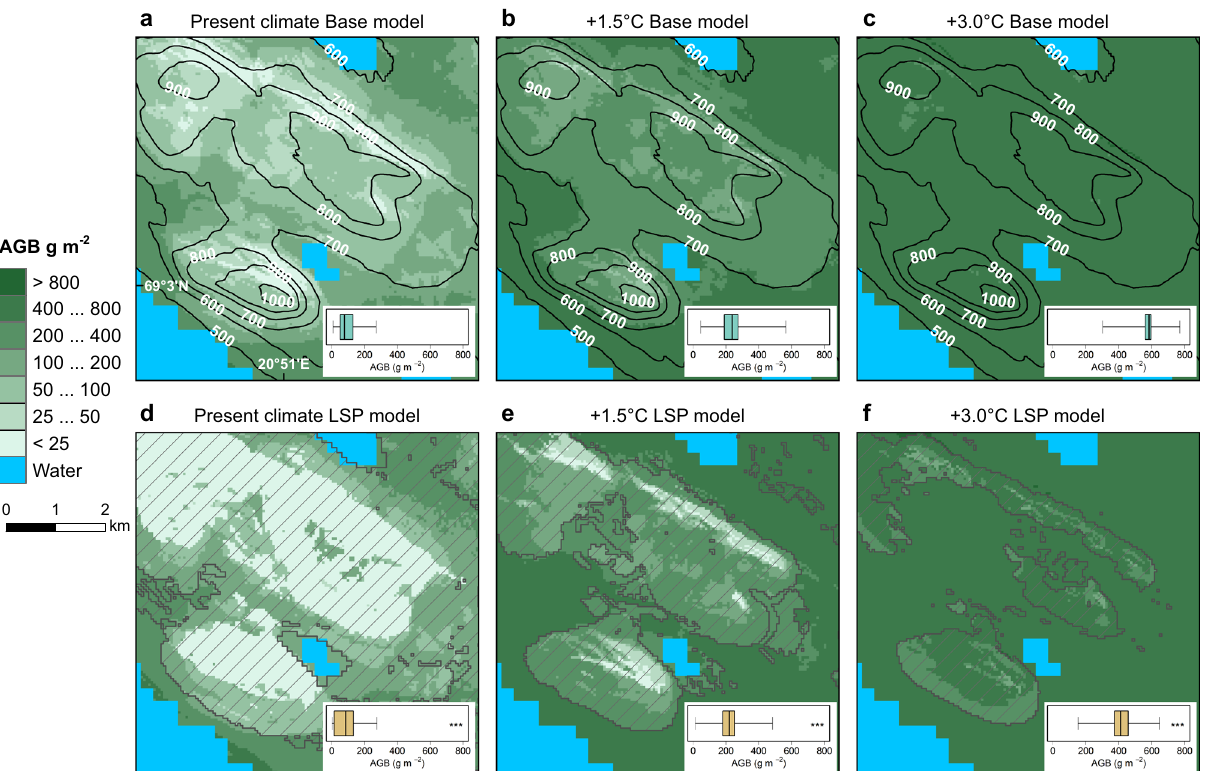
Fig. 4 Above-ground biomass (AGB) patterns in tundra are constrained by cryogenic land surface processes (LSP). The close-ups ( a – c Base model, d – f LSP model) show the predicted AGB in a topographically heterogeneous landscape (ca. 69°03 ’ N, 20°51 ’ E) at present climate (1981 – 2010), and under two mean annual air temperature warming scenarios (i.e., + 1.5 °C and + 3.0 °C), respectively. In a – c , the contours depict elevation from sea level; in d – f , the gray hatched polygons encompass the areas suitable for the occurrence of LSP (i.e., the LSP realm) at each warming scenario. The boxplots indicate the AGB variation (black line depicting median, the whiskers extending to 1 st and 99 th percentile) within the LSP realm. Asterisks